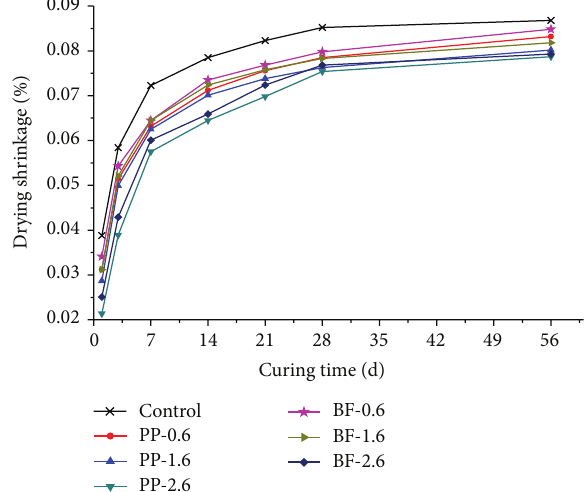
Figure 6: Drying shrinkage curves of FRM at different fiber contents.